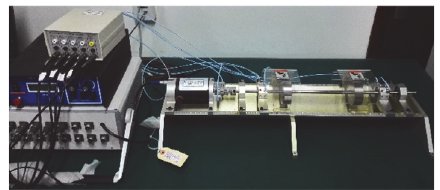
Figure 8: Bently RK4 rotor test